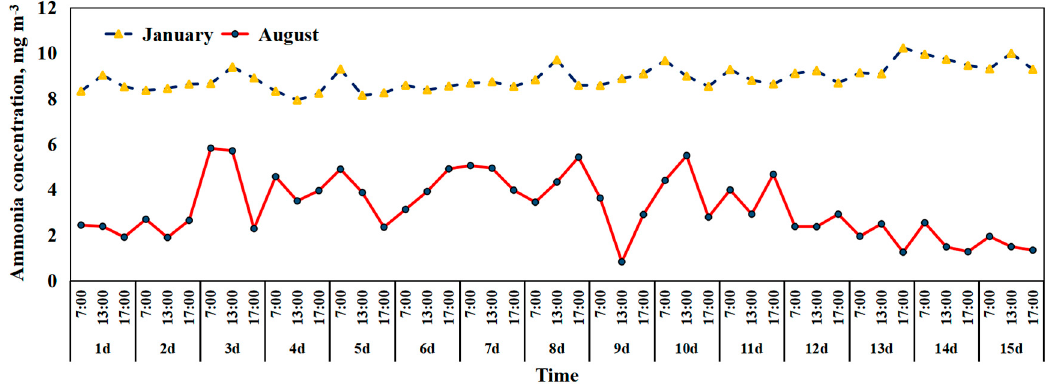
Figure 4. Ammonia concentration variations among different sampling times during winter and summer.